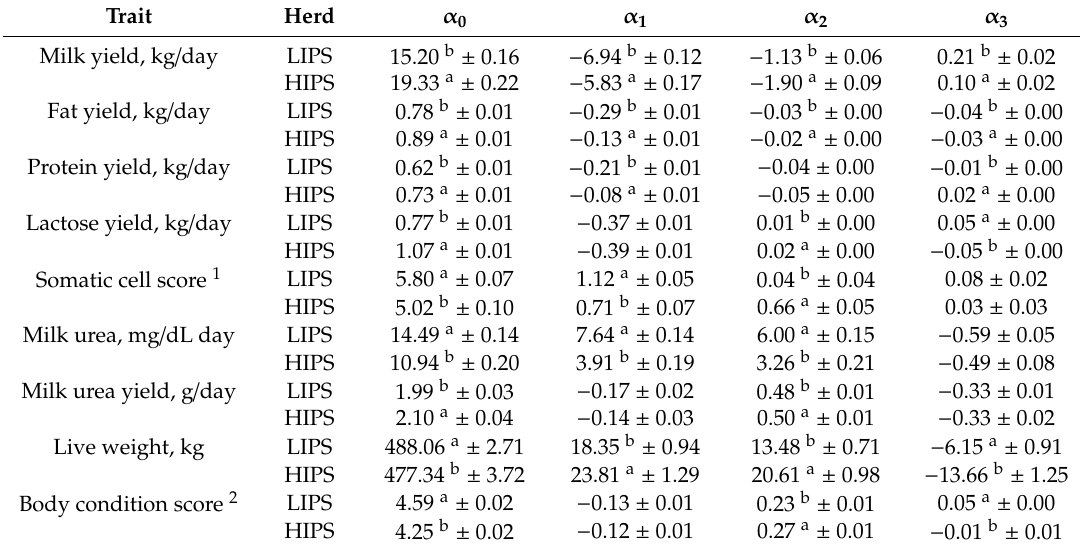
Table 4. Least squares means and standard errors of the estimates of regression coe ffi cients of the lactation curves for milk, fat, protein and lactose yields, somatic cell score, milk urea nitrogen (MUN) and MUN yield, body weight and body condition score modelled with a third-order Legendre polynomial fitted to grazing cows throughout a full lactation in two contrasting pasture-based dairy production systems: a low-intensity production system (LIPS) and a high-intensity production system (HIPS).